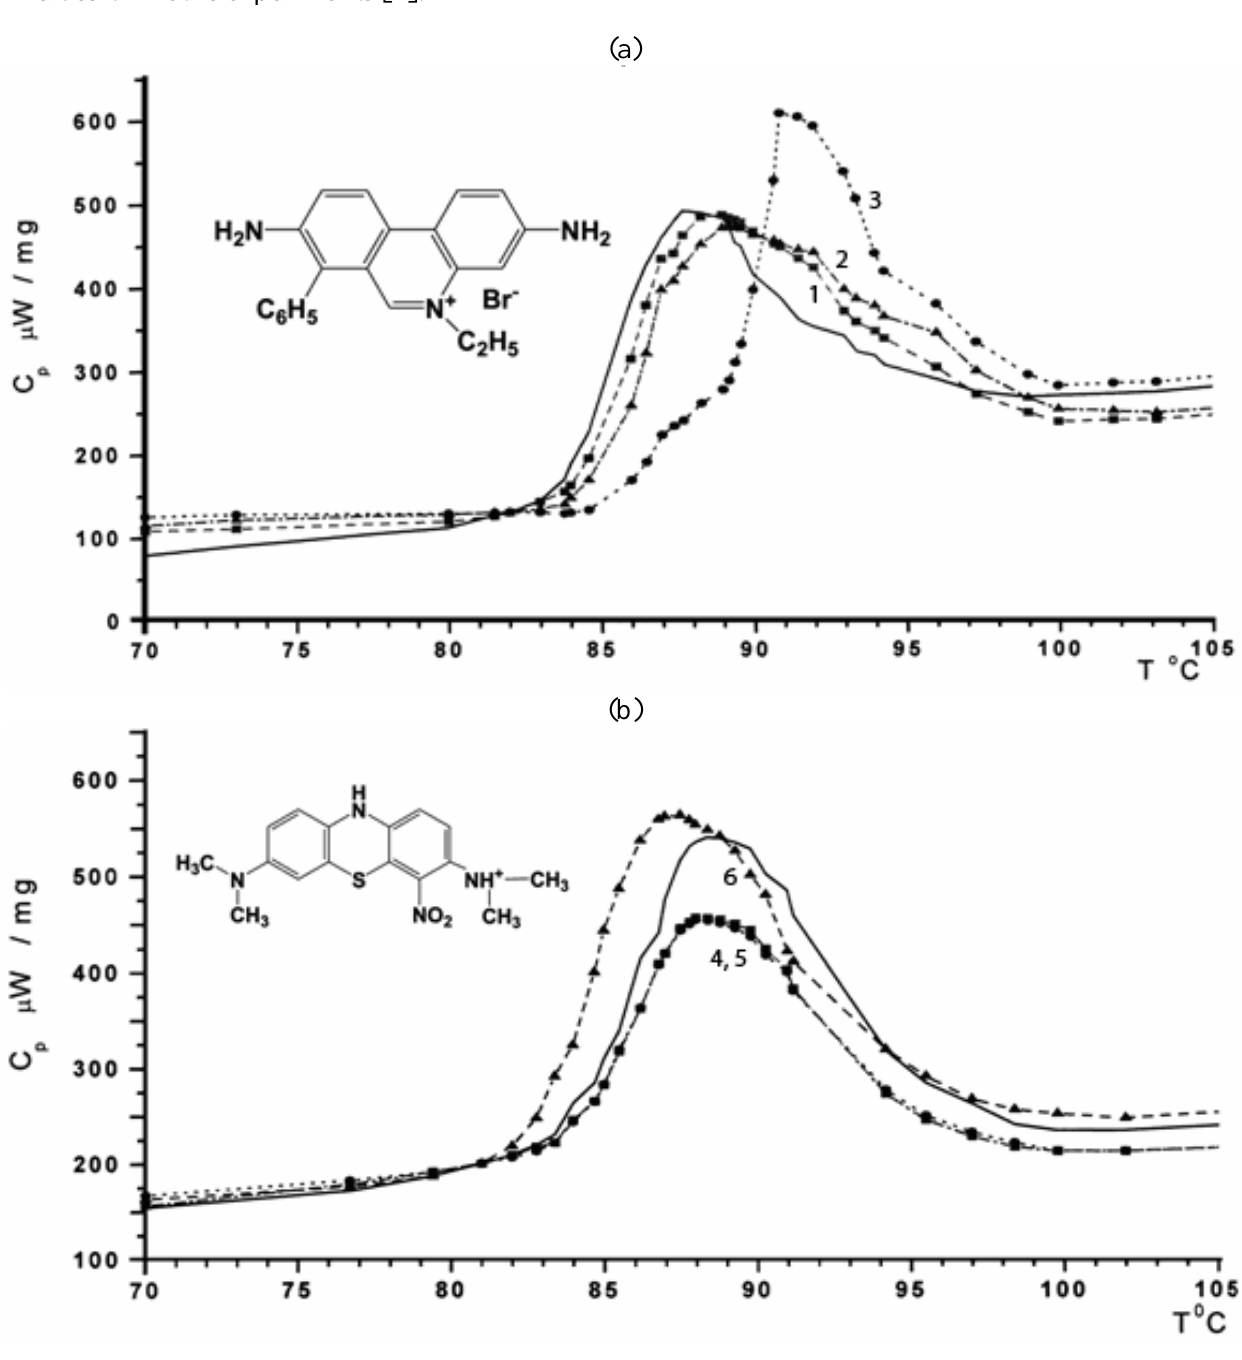
Figure 2. Melting curves of ds-DNA (solid curves) and of its mixtures (dashed curves) with ethidium bromide (a, (1) - 10, (2) - 12 and (3) - 15 µ g mL -1 ) and MB (b, (4) -5, (5) - 10 and (5) - 15 µ g mL -1 ). C – specific heat